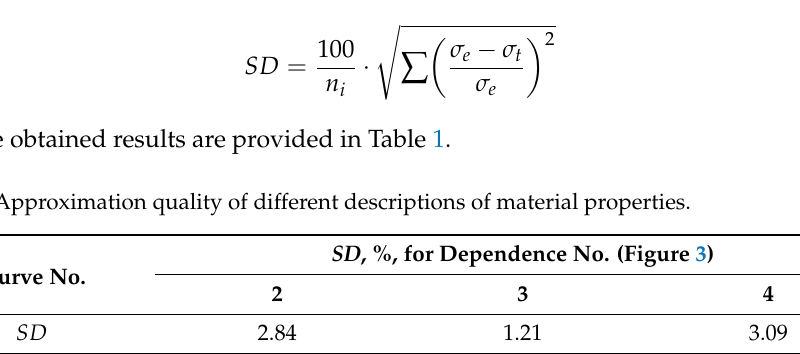
Table 1. Approximation quality of different descriptions of material properties. Curve No.